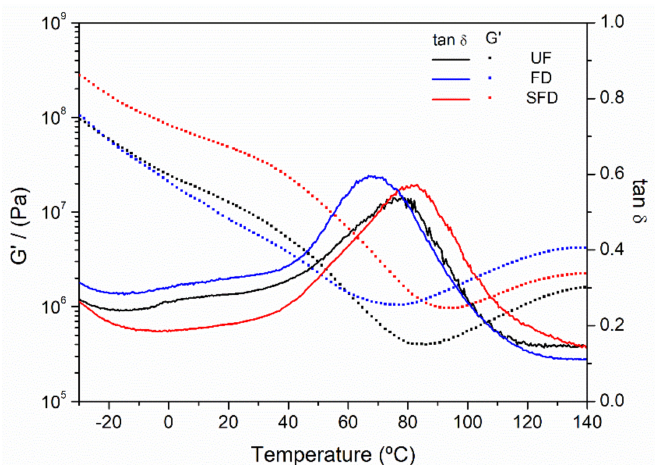
Figure 4. Evolution of the storage (G (cid:48) ) and viscous (G”) moduli in torsion mode for porcine plasma protein-glycerol materials using UF, FD, and SFD protein systems, obtained through temperature sweep tests from 30 to 140 ◦ C at 1 Hz within the lineal viscoelastic